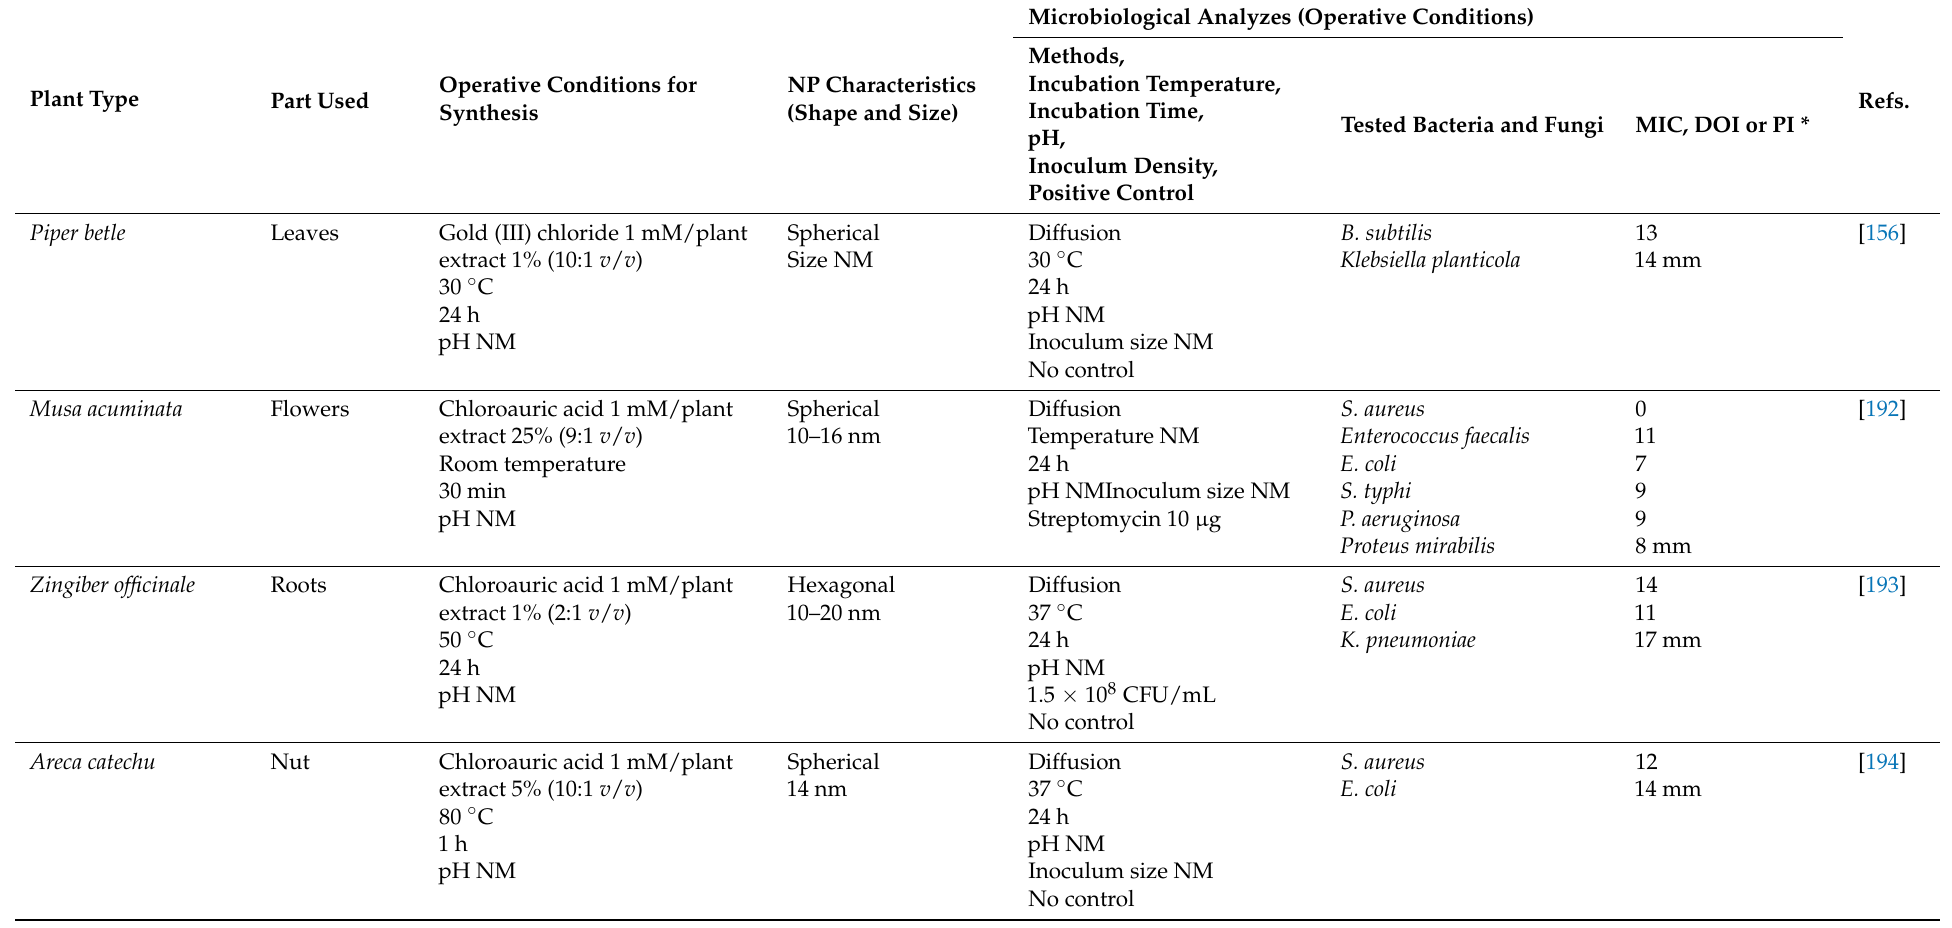
Table 3. Green gold nanoparticles exhibiting antibacterial and antifungal